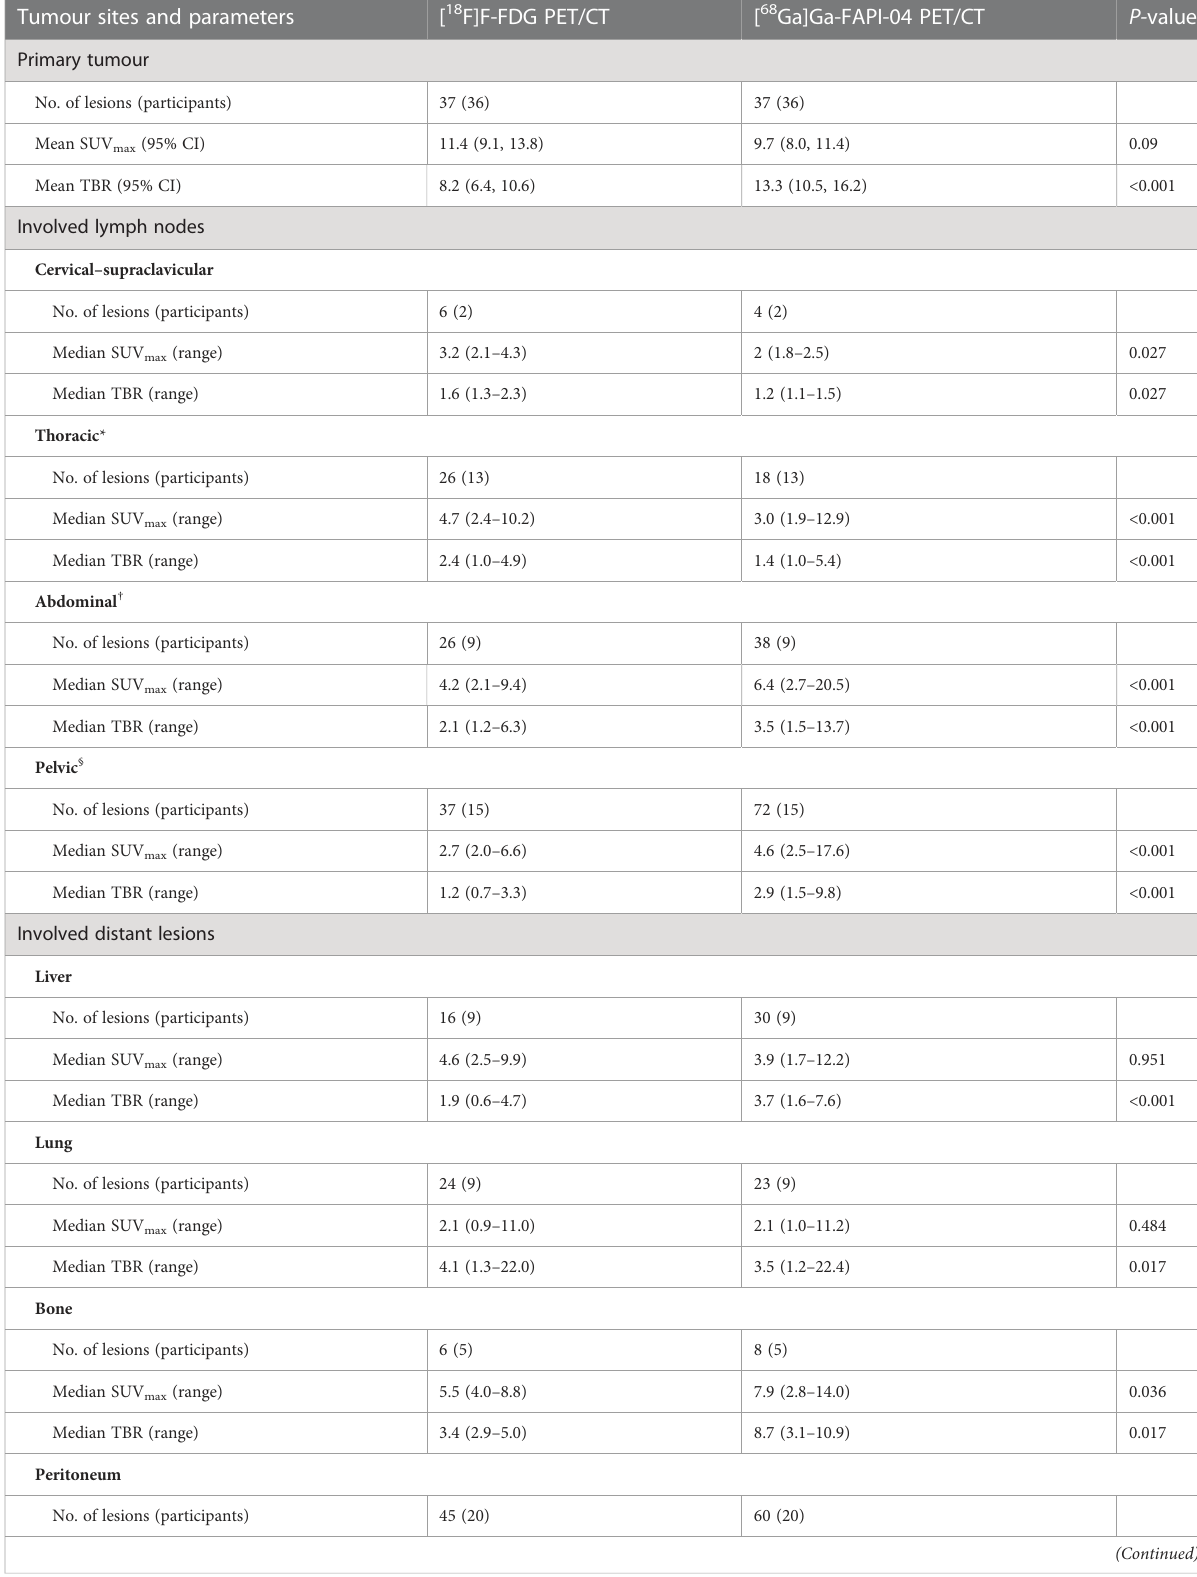
TABLE 3 Comparison of [ 18 F]F-FDG and [ 68 Ga]Ga-FAPI-04 uptake in colorectal tumour sites. Tumour sites and